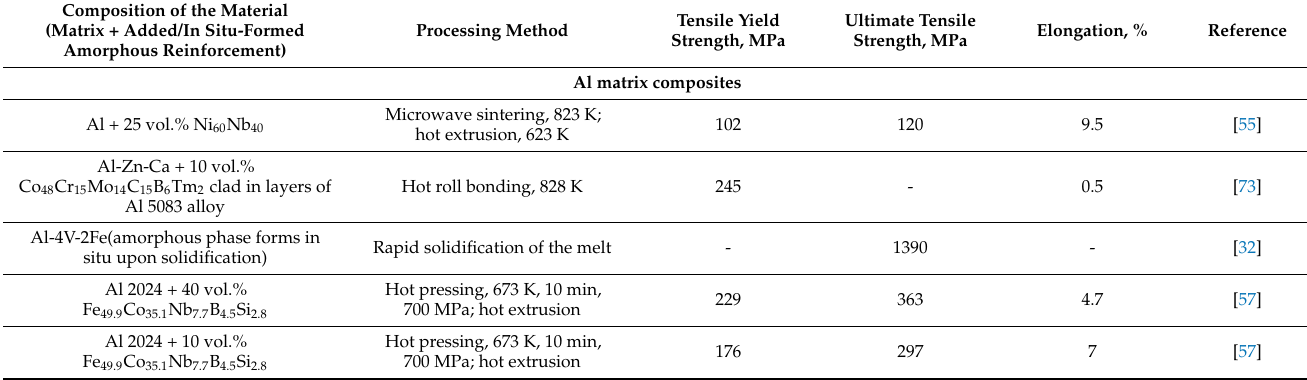
Table 6. Mechanical properties of selected metallic glass (amorphous alloy)-particle-reinforced MMCs in